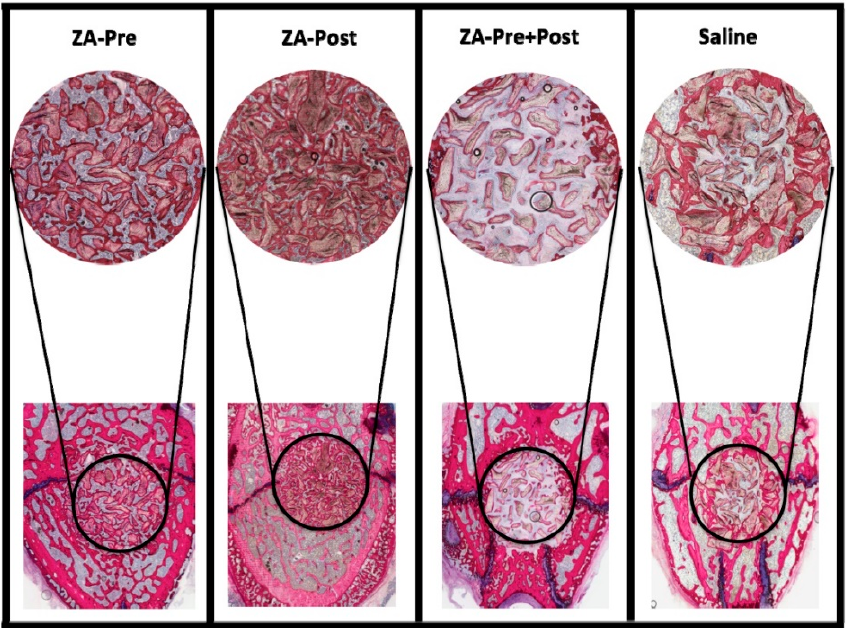
Figure 2. Representative histological sections of specimens from different study groups showing a transverse section through the femoral condyle, perpendicular to the long axis of the cylindrical bone defect. A circular region depicting the region of interest (ROI) is shown separately as an offset image for each group.